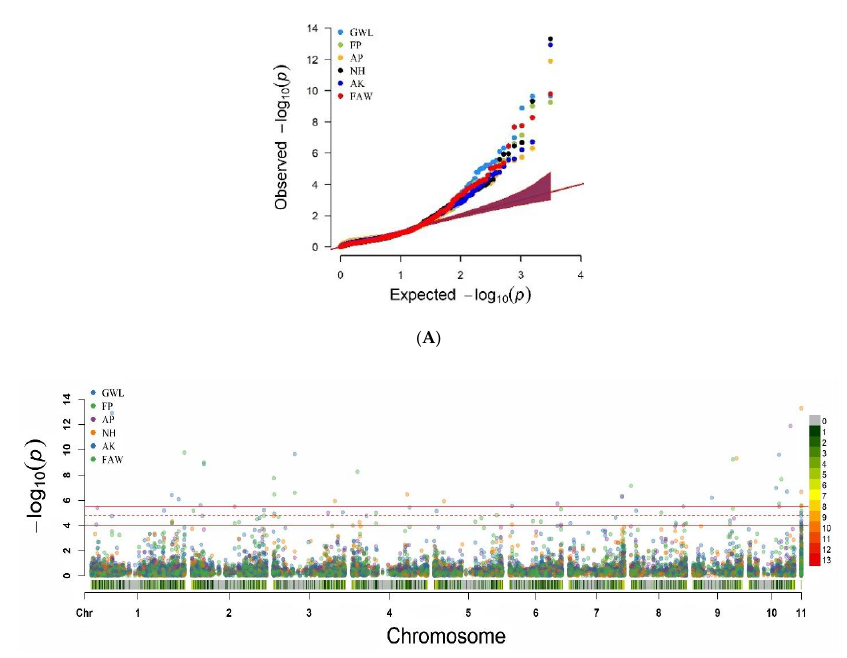
Figure 3. 3D and 2D distribution of the maize lines composing the association mapping panel according to the first three principal components (PC1, PC2, and PC3) generated from the 3124 LD- pruned markers.